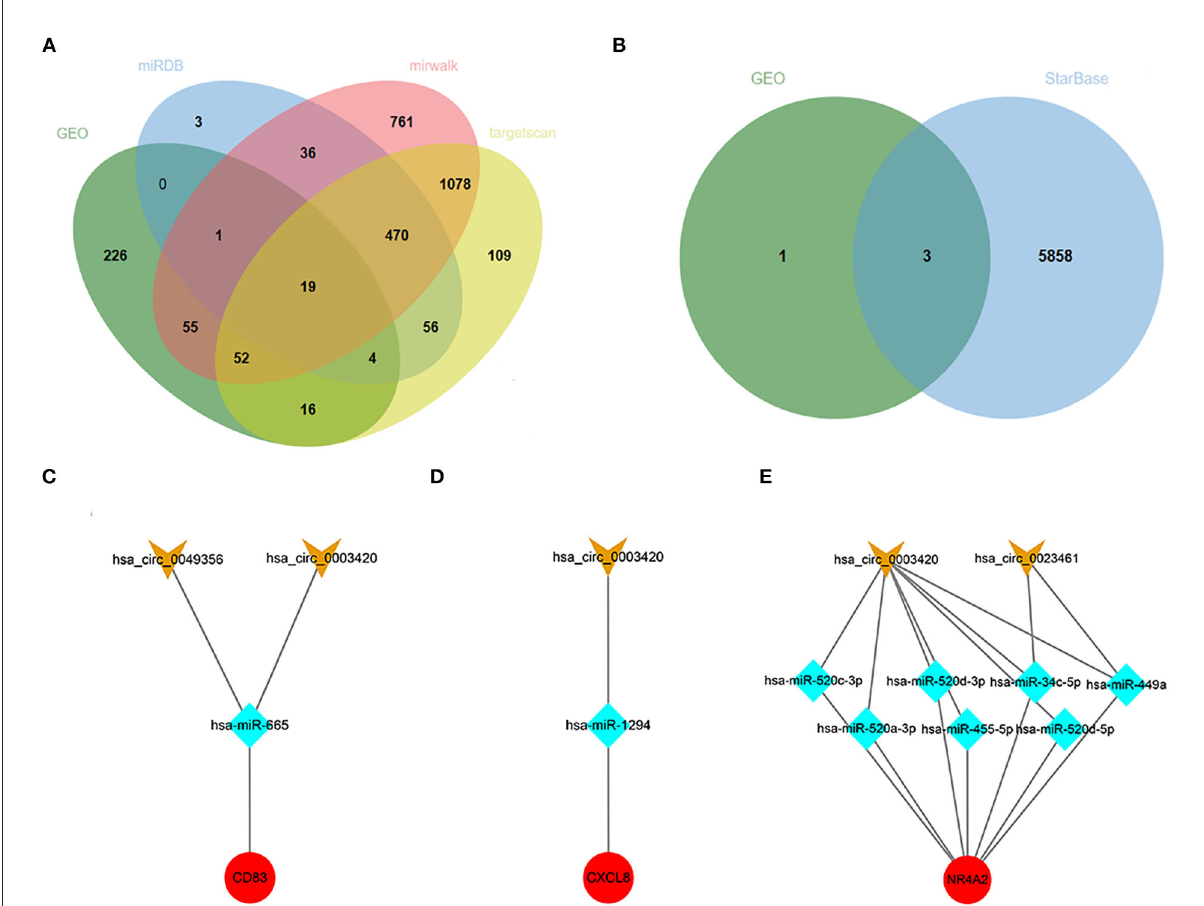
FIGURE8 Target ncRNAs Prediction and Network Construction. (A) Venn diagram of overlapped miRNAs from the GSE31568 dataset and online miRNA databases. (B) Venn diagram of overlapped circRNAs from GSE160717 dataset and online circRNAs databases. (C–E) Three ceRNA network of CD83 , CXCL8, and NR4A2 . Red nodes represent hub genes, blue nodes represent miRNAs, and orange nodes represent